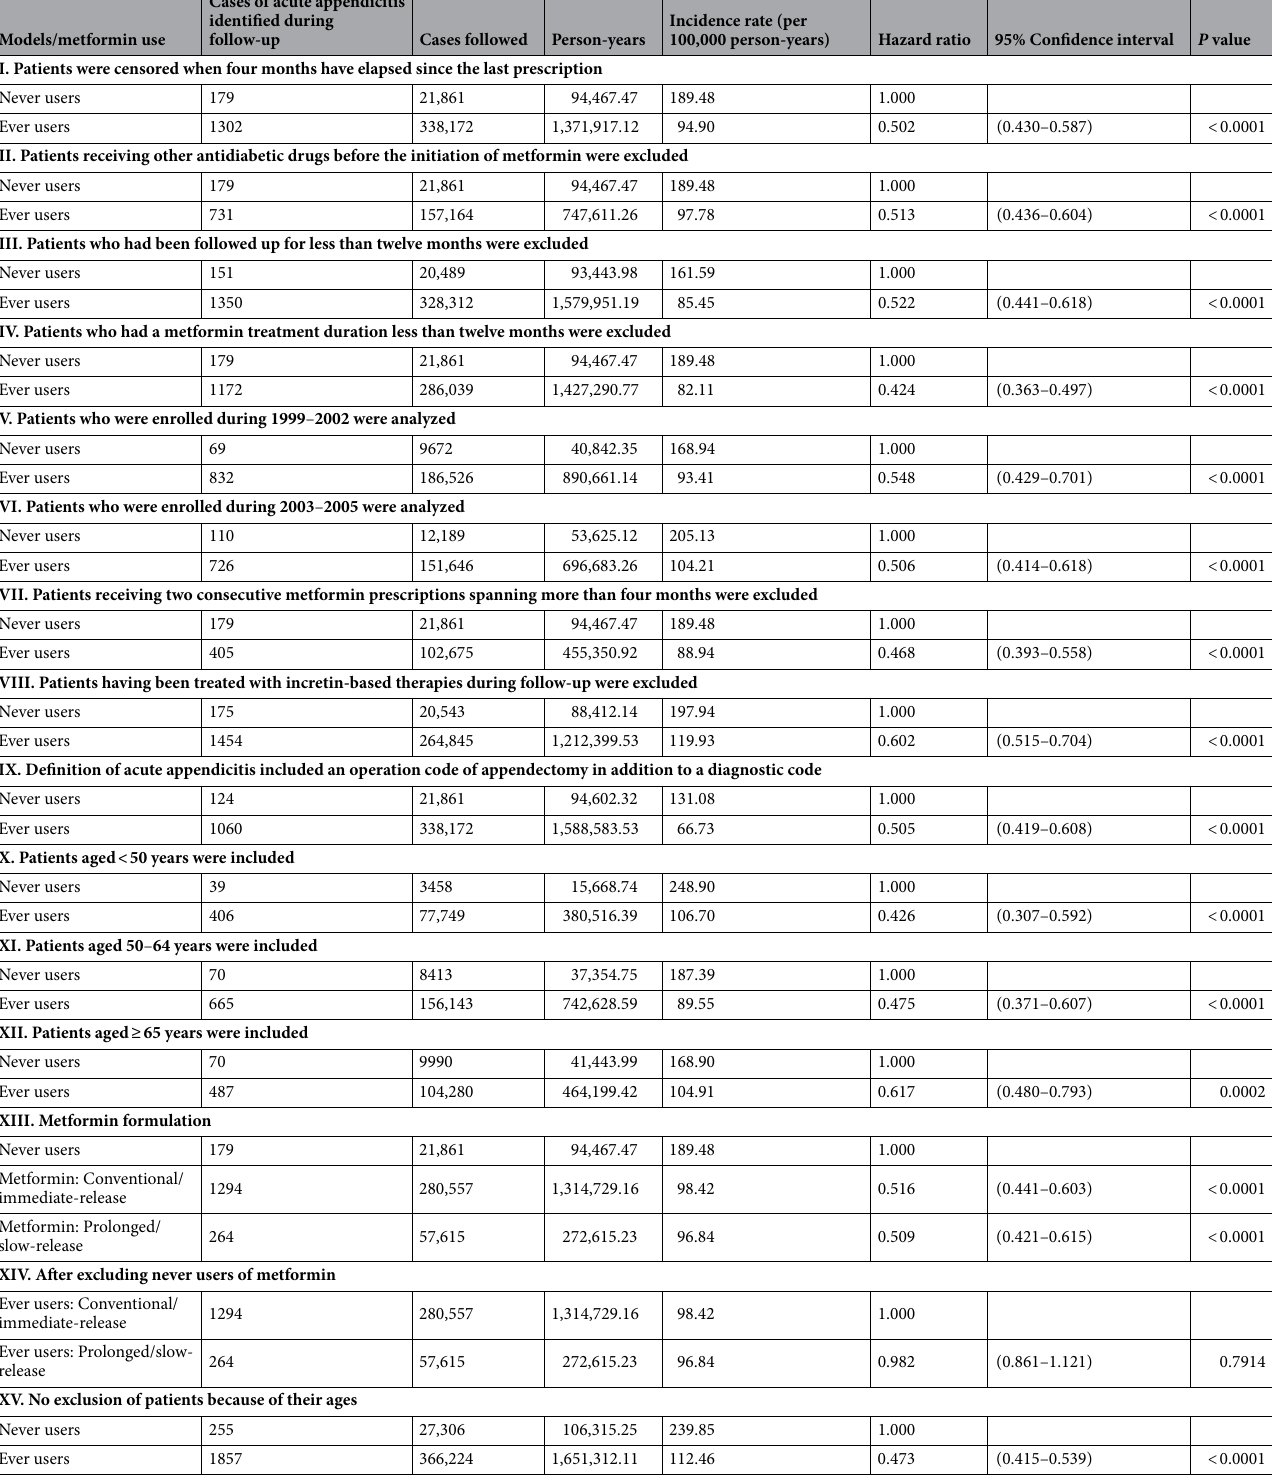
Table 3. Sensitivity